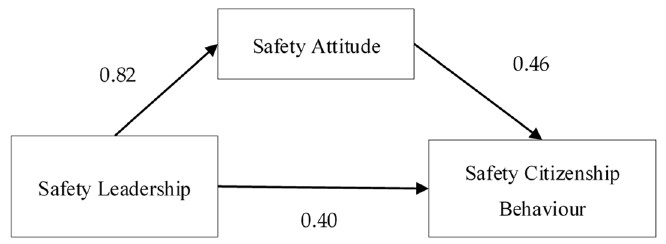
Table 5. Model fitting index for SA, SL and SCB measurement models.